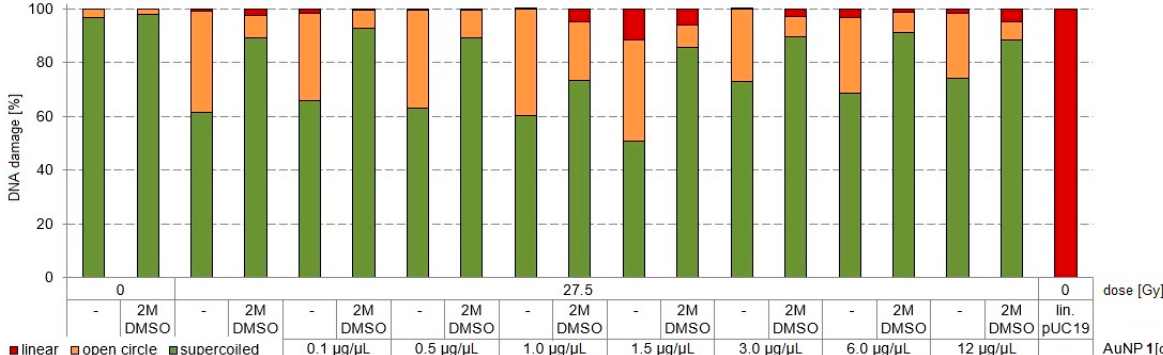
Figure 4. Irradiation experiments with 27.5 Gy Re-188 at different concentrations of AuNP-PEG 1 for pUC19 only, pUC19 with AuNPs and pUC19 with AuNPs in combination with DMSO. sc pUC19 is expressed as green bar, the extend of oc is expressed in orange and the extend of lin plasmid in red.